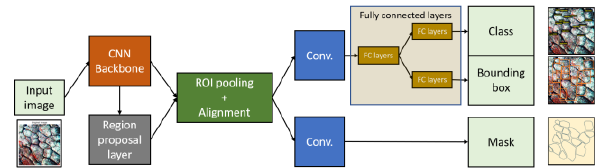
Figure 2. Simplified block diagram of the Mask R-CNN model.